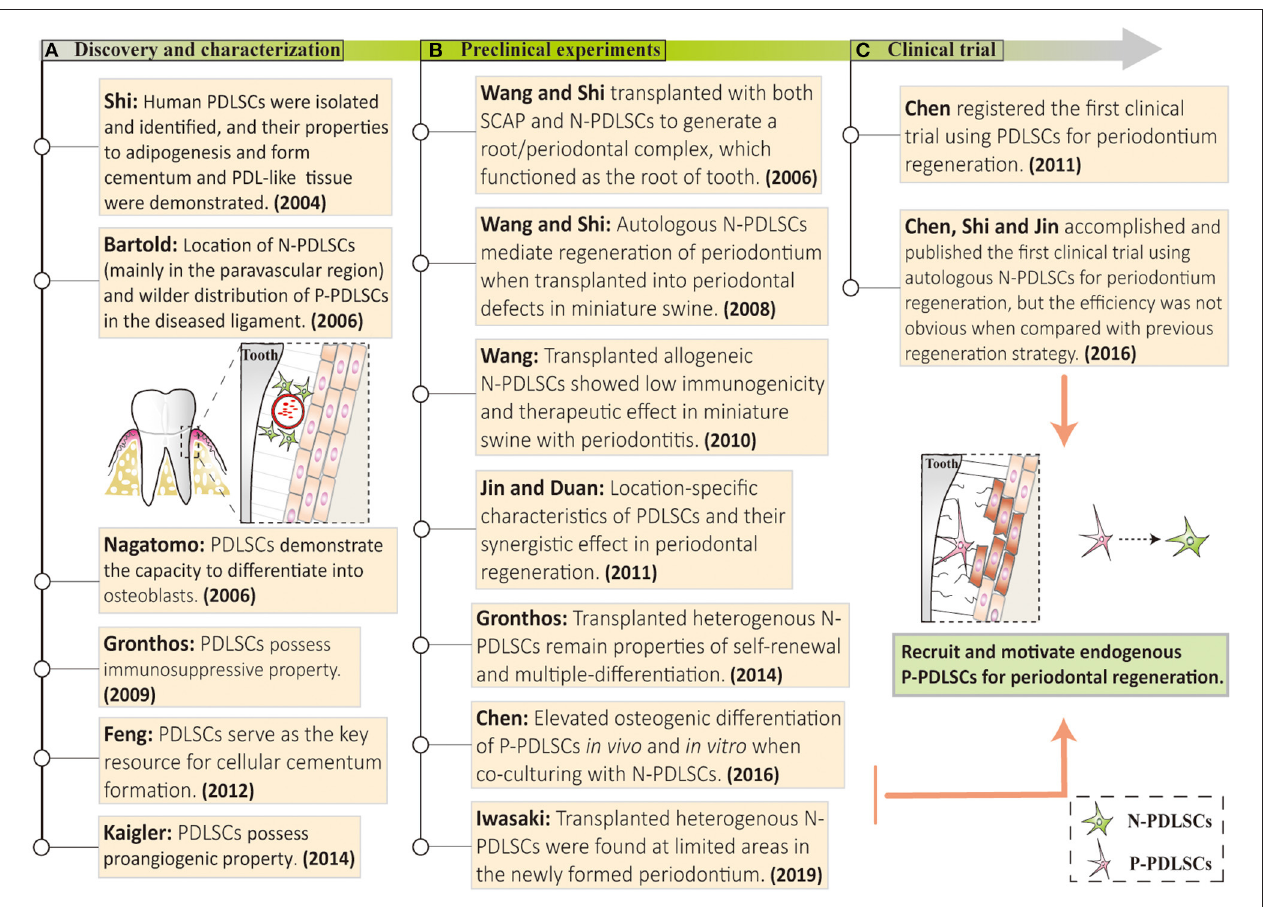
FIGURE 3 | Discovery and application of PDLSCs in vitro and in vivo . (A) Studies over the past decade have described the excellent therapeutic potential of PDLSCs, including self-renewal, angiogenesis, immunomodulation, and multiple differentiation properties. (B) Some animal experiments based on PDLSCs transplantation have been carried out and achieved satisfactory periodontal regeneration. (C) A clinical trial of PDLSC-mediated periodontitis treatments has been successfully conducted, but the effects of repairing periodontium were not noticeable. These studies above may set an emerging direction to recruit and mobilize endogenous P-PDLSCs for periodontal regeneration. N-PDLSCs, normal PDLSCs; P-PDLSCs, periodontitis-derived